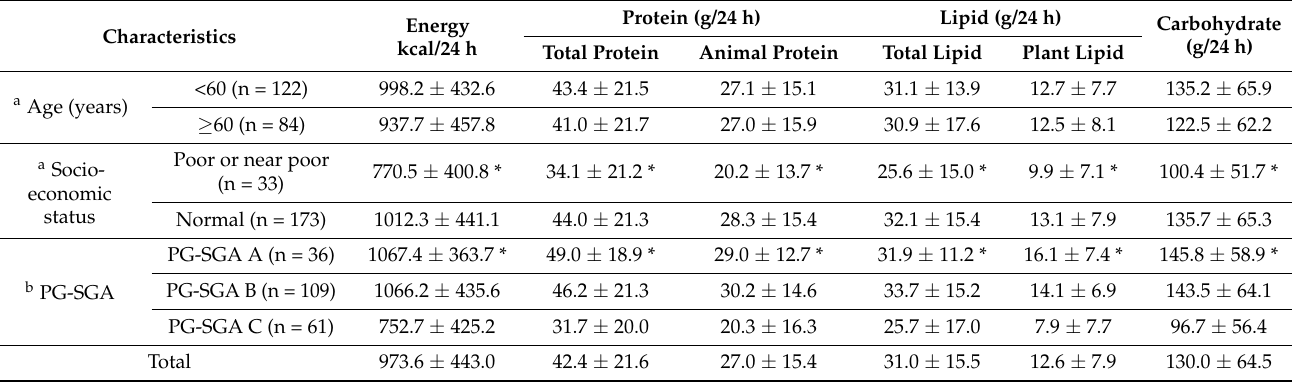
Table 5. Dietary intake in 24 h recall before